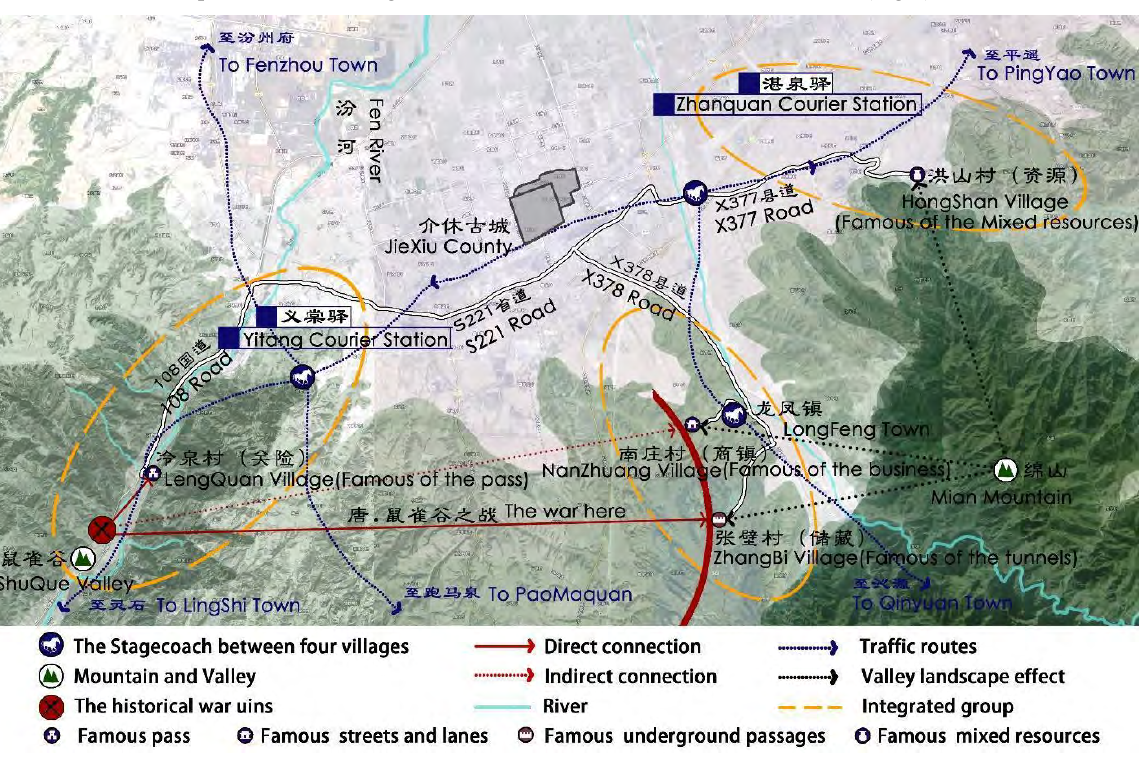
Figure 6 Four villages’ development